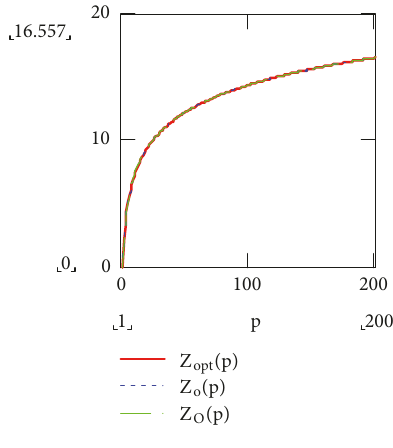
Figure 2: Objective functional value.